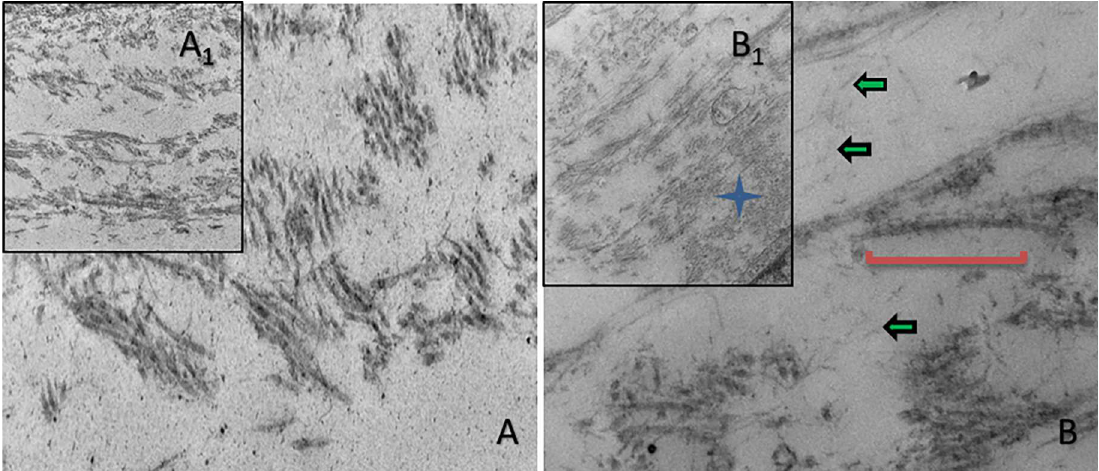
Fig 1. TEM image showing corneal matrix status. HCF.C and HKC.C: pre-CXL, and HCF.X and HKC.X: post-CXL, when cultured in our 3D model. Green arrows: proteoglycans; Blue star: collagen fibrils organization; Red line: collagen banding.